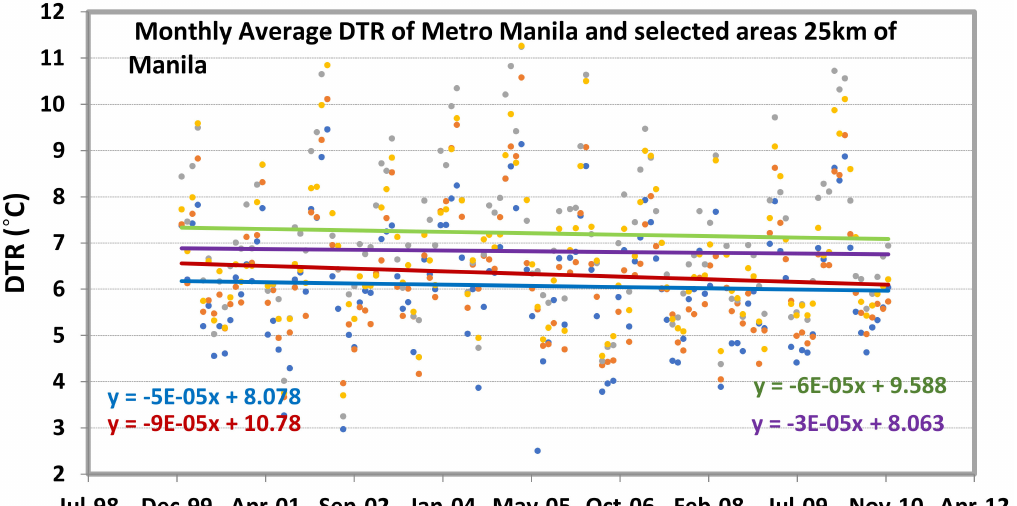
Figure 8. Decreasing diurnal temperature range (DTR, ◦ C) of Metro Manila (blue) and 25 km south (red), 25 km north (green) and 25 km east (violet) of Manila. Decreasing rate is largest at 25 km south. Decreasing trends were measured for Metro Manila, 25 km north, 25 km south and 25 km